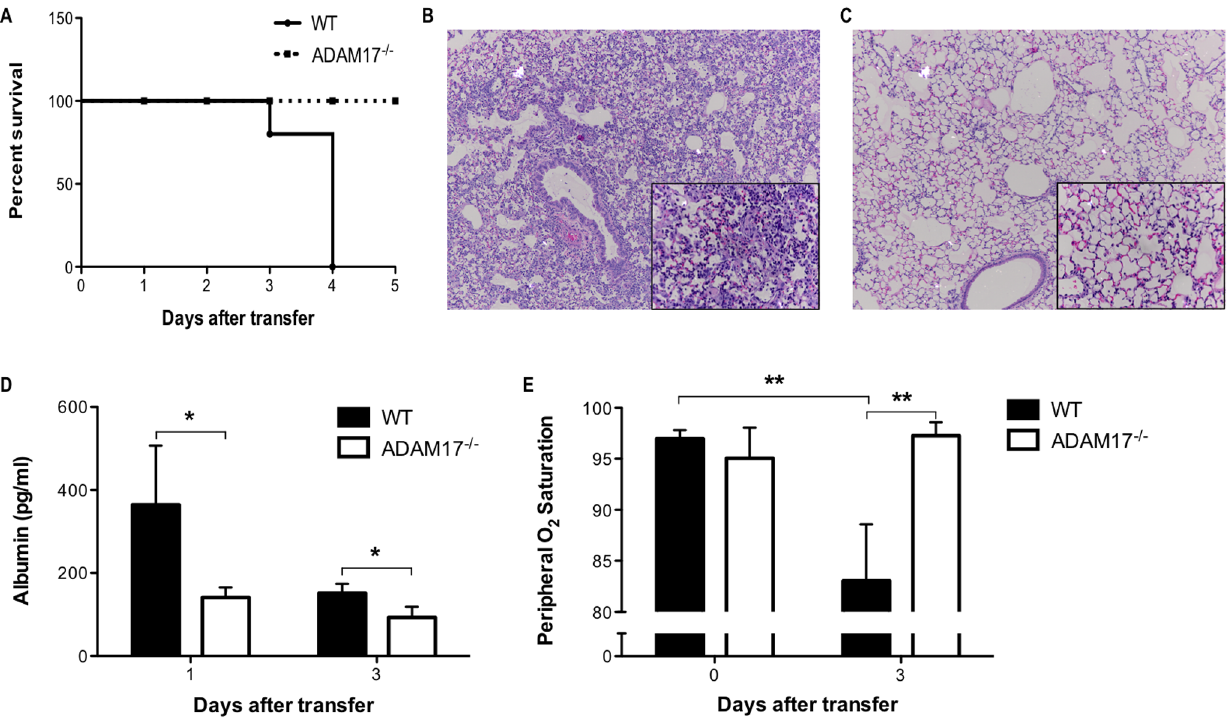
Figure 5. ADAM17 expression on transferred CD8 + T cells is required for acute lung injury. SPC-HA transgenic mice received WT or ADAM17 2 / 2 HA-specific CD8 + T cells via tail vein injection. (A) Survival of mice after transfer of 10 7 T cells was monitored and a difference in survival ( P , 0.05) was observed. Representative H&E stained lung sections from SPC-HA transgenic mice harvested 5 days after transfer of 5 6 10 6 (B) WT or (C) ADAM17 2 / 2 CD8 + T cells shown at 10x magnification with 40x inset. (D) ELISA was used to assess the levels of albumin in cell-free BAL fluid after transfer of 10 7 T cells. (E) Peripheral oxygen saturation was measured in mice before and after transfer of 10 7 T cells using the MouseOx System. Data represent mean 6 standard deviation. Data are representative of at least three independent experiments with 3-4 mice per group. * P , 0.05, ** P , 0.01.